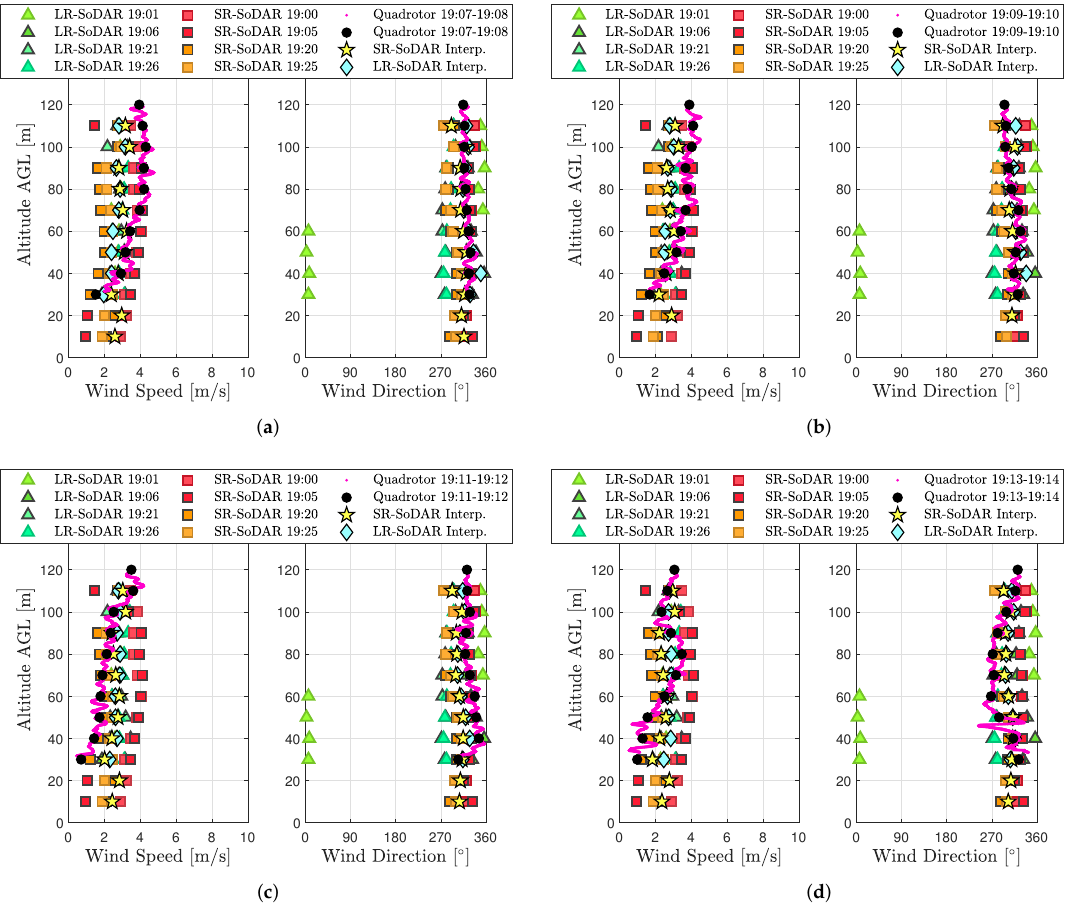
Figure A8. Comparison of wind speed and wind direction profiles from the SoDAR and quadrotor ascending vertically at 2.0 m/s between 10 and 120 m AGL from ( a ) 19:07 to 19:08 EDT, ( b ) 19:09 to 19:10 EDT, ( c ) 19:11 to 19:12 EDT, and ( d ) 19:13 to 19:14